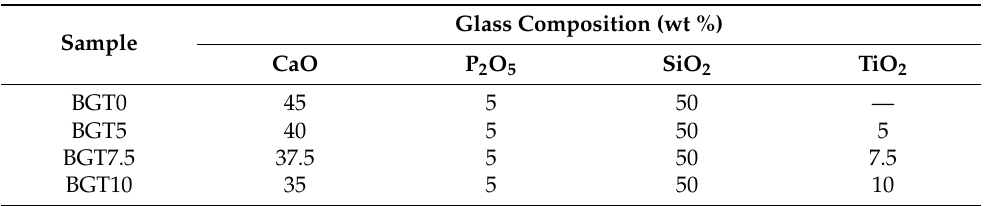
Figure 1. Differential thermal analysis curve of BGT10 with reference to that of native glass (Base). Table 1. Composition (weight %) of glass doped with titanium.